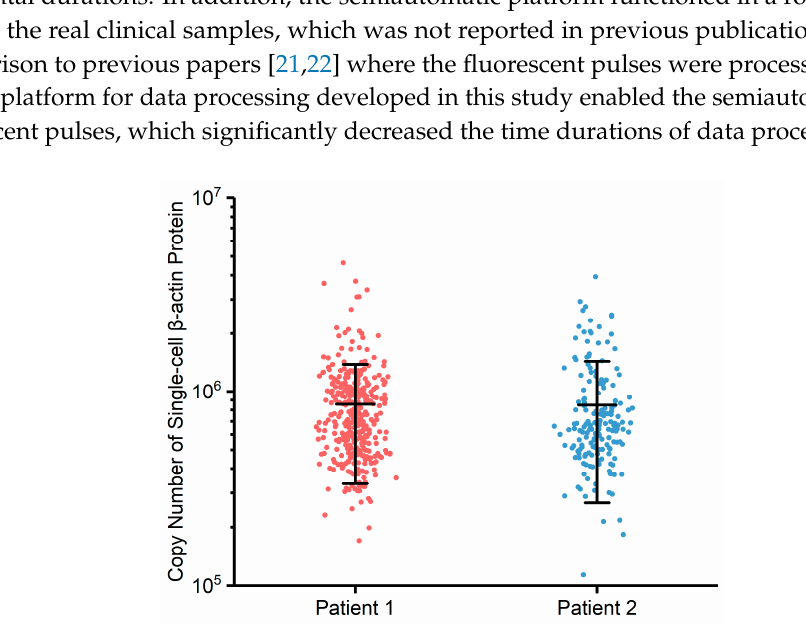
Figure 5. Scatter plots of the copy numbers of single-cell β -actin proteins from two oral tumor patients. These results indicated that the developed instrument could be used to absolutely quantify specific intracellular proteins of patient samples at the single-cell level.